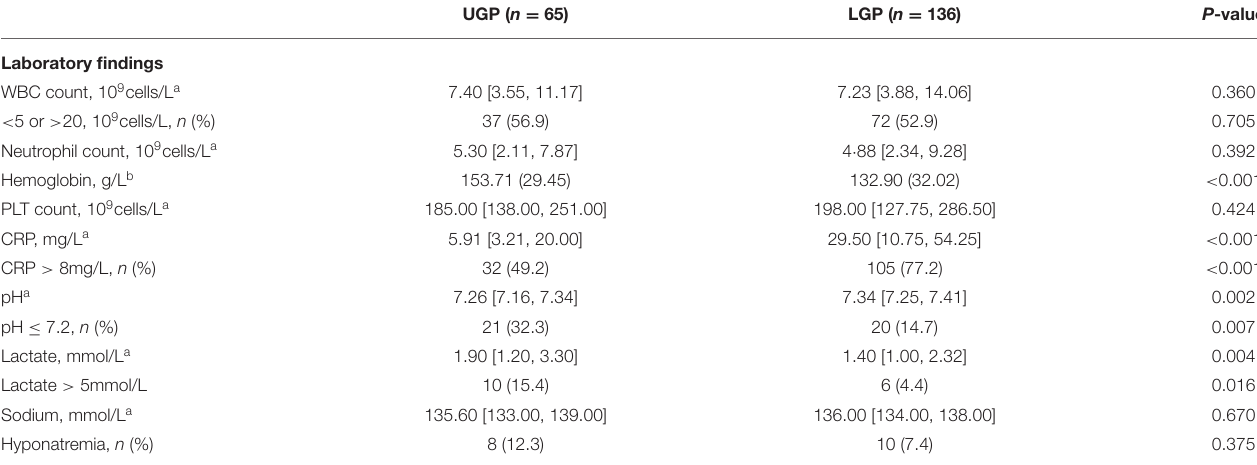
TABLE 2 | Laboratory findings of